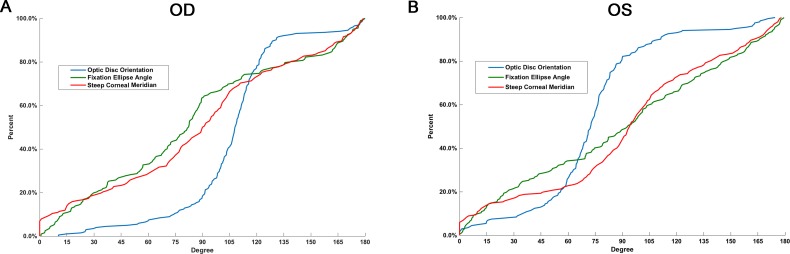
Cumulative distribution function curves for optic disc orientation, fixation ellipse angle, and steep corneal meridian in the right (A) and left (B) eyes. Distribution pattern of steep corneal meridian seemed more similar to that of the fixation ellipse angle than to the distribution of the optic disc orientation. However, statistically significant differences were found in their distributions (Kolmogorov–Smirnov test, cornea vs. fixation: right eye, P = 0.003; left eye, P = 0.021; cornea vs. disc, both eyes, P < 0.001).